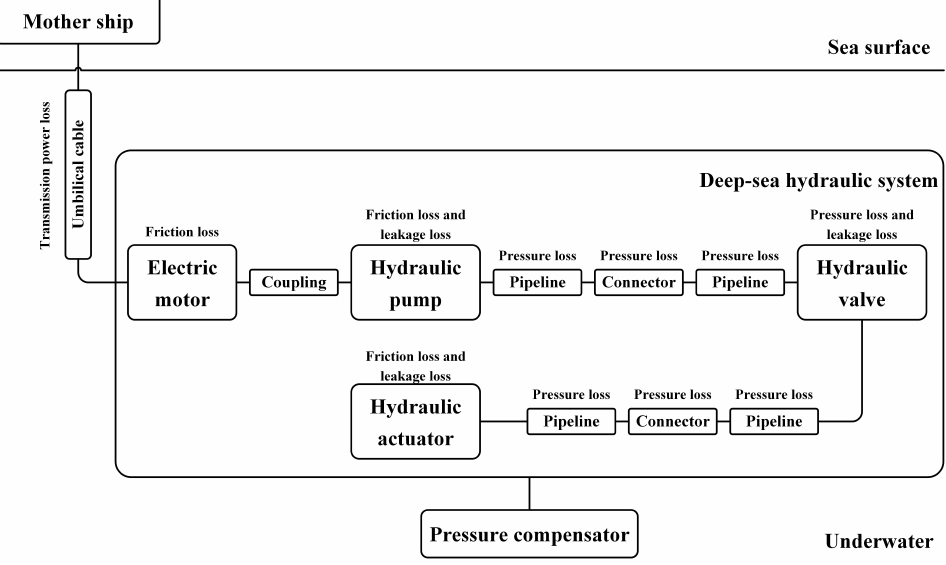
Figure 1. Power transmission block diagram of deep-sea operation